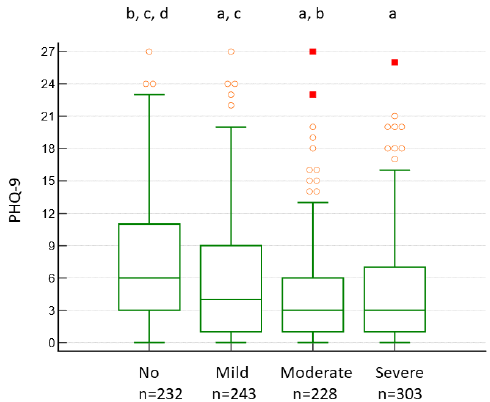
Figure 5. Box-and-whisker plot for PHQ-9 scores according to OSA severity. Patients with AHI/REI < 5, 5 ≤ AHI/REI < 15, 15 ≤ AHI/REI < 15, and 30 ≥ AHI/REI were classified as having no, mild, moderate, and severe OSA, respectively. OSA, obstructive sleep apnoea; PHQ-9, Patient Health Questionnaire-9; AHI, apnoea – hypopnea index; REI, respiratory event index; ■ , far outside values; ○ , outside values; a, p < 0.05 vs. no; b, p < 0.05 vs. mild; c, p < 0.05 vs. moderate; d, p < 0.05 vs. severe.